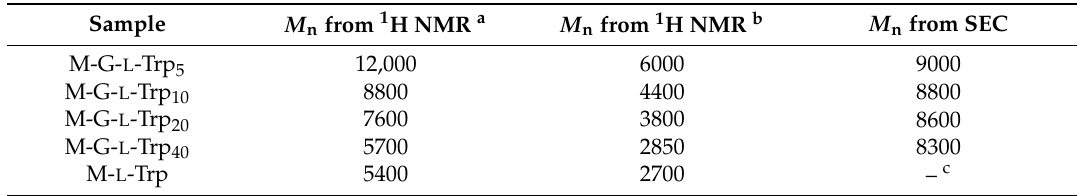
Table 2. Homo- and copolymers M n evaluation by NMR and SEC: comparison between calculated and experimental M n values.